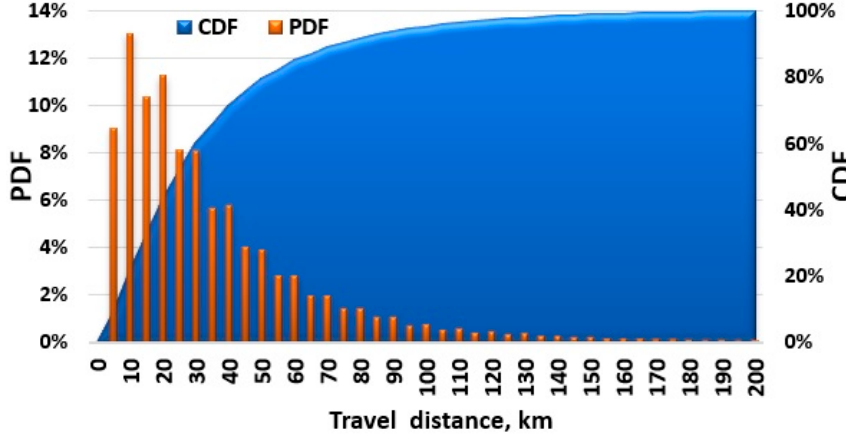
Figure 1. CDF and PDF of the daily travel distance.